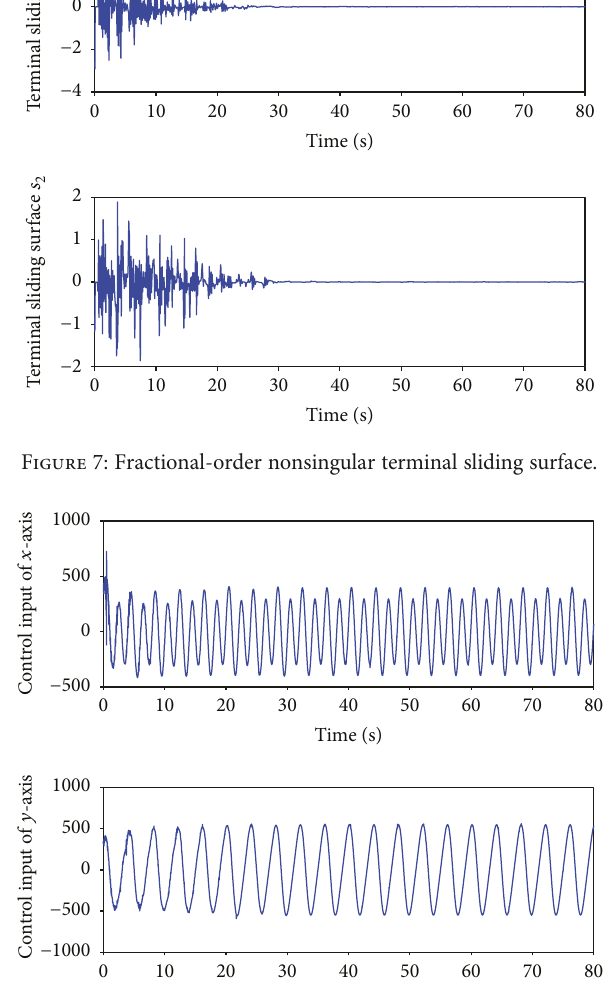
Figure 10: Adaption of spring constants of the